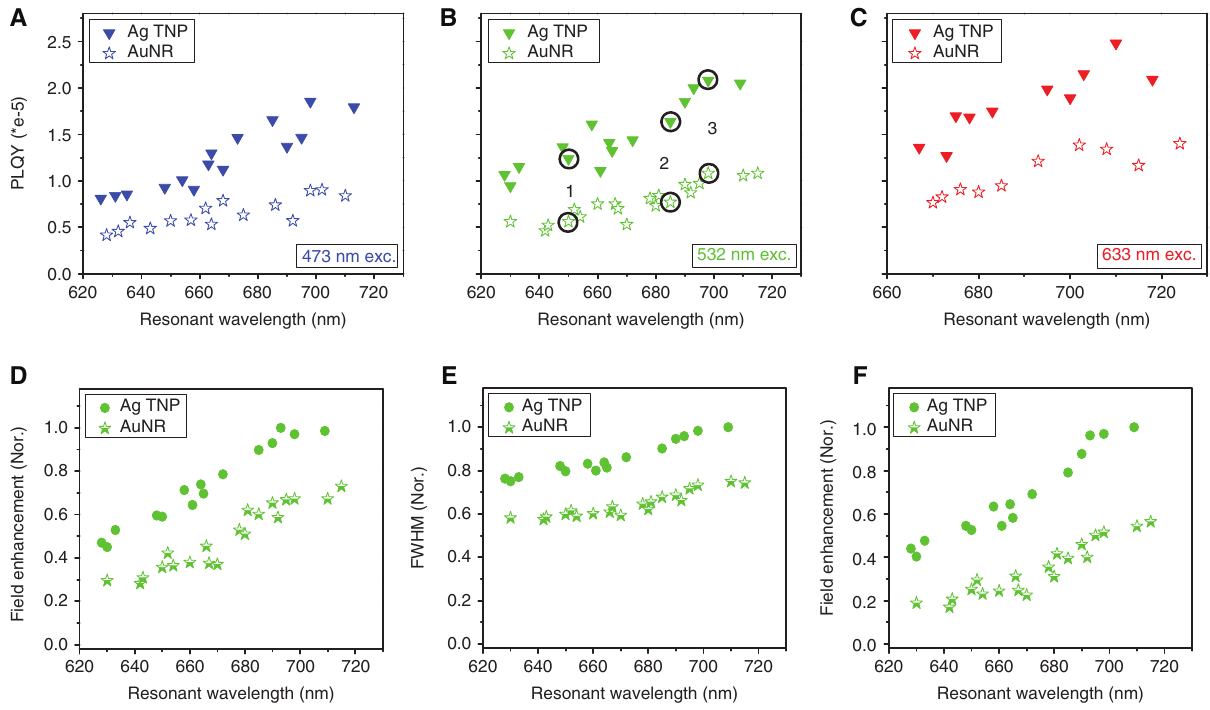
Figure 5: PL QY and simulated field enhancement of Ag TNPs and Au NRs. (A–C) PL QY of a series of Ag TNPs and Au NRs at different resonant wavelengths under excitations at 473, 532, and 633 nm, respectively. The PL spectra of Au NRs were taken with the excitation polarization direction aligned with its longitudinal mode. Corresponding to the NPs in (B), the simulated field enhancement integrated in the volume surrounding the NPs with a thickness of 20 nm from the surface at the peak of the resonant wavelengths, the FWHM of the SPR response are shown in (D) and (E), respectively. Note that the simulation results are normalized to the maximum for comparison. (F) The field enhancement integrated in the same volume as in (D) but under the whole SPR response (550–850 nm) as a function of the resonant